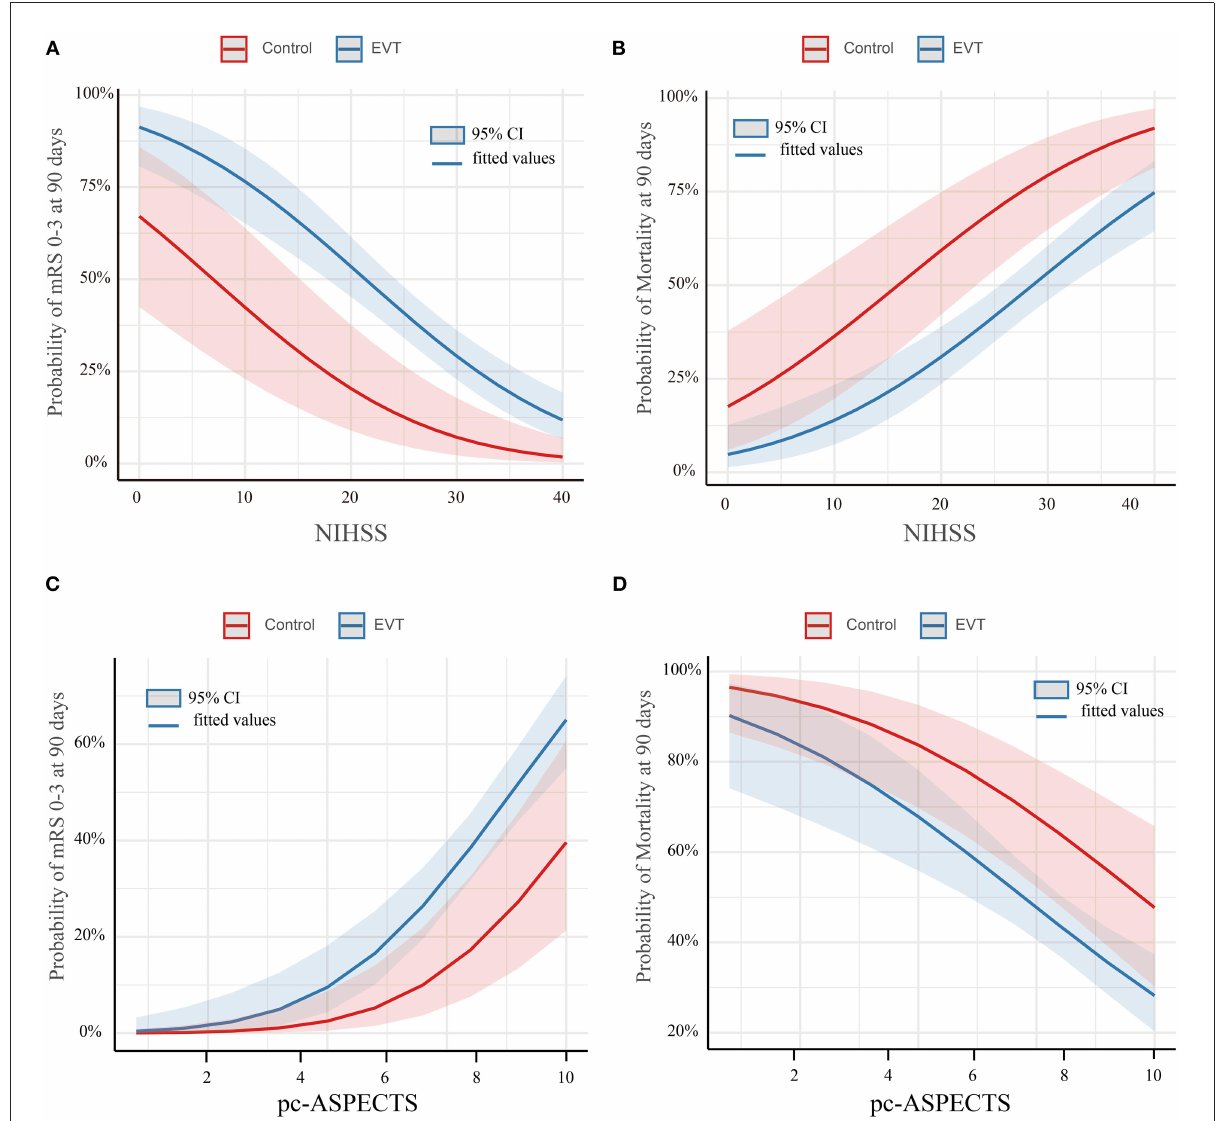
FIGURE3 Predicted probability of clinical outcomes by NIHSS score and pc-ASPECTS in patients with distal BAO. Predicted probability of a favorable outcome (A) and mortality (B) by NIHSS in patients with distal BAO and the predicted probability of a favorable outcome (C) and mortality (D) by pc-ASPECTS in patients with distal BAO. Curves showed that among patients with distal BAO, the EVT group showed a higher predicted rate of favorable functional outcome and a lower predicted rate of mortality than the SMT group. Shading indicates the 95% confidence interval. BAO, basilar artery occlusion; EVT, endovascular treatment; NIHSS, National Institutes of Health Stroke Scale; pc-ASPECTS, posterior circulation-Alberta Stroke Program Early CT Score; SMT, standard medical treatment.